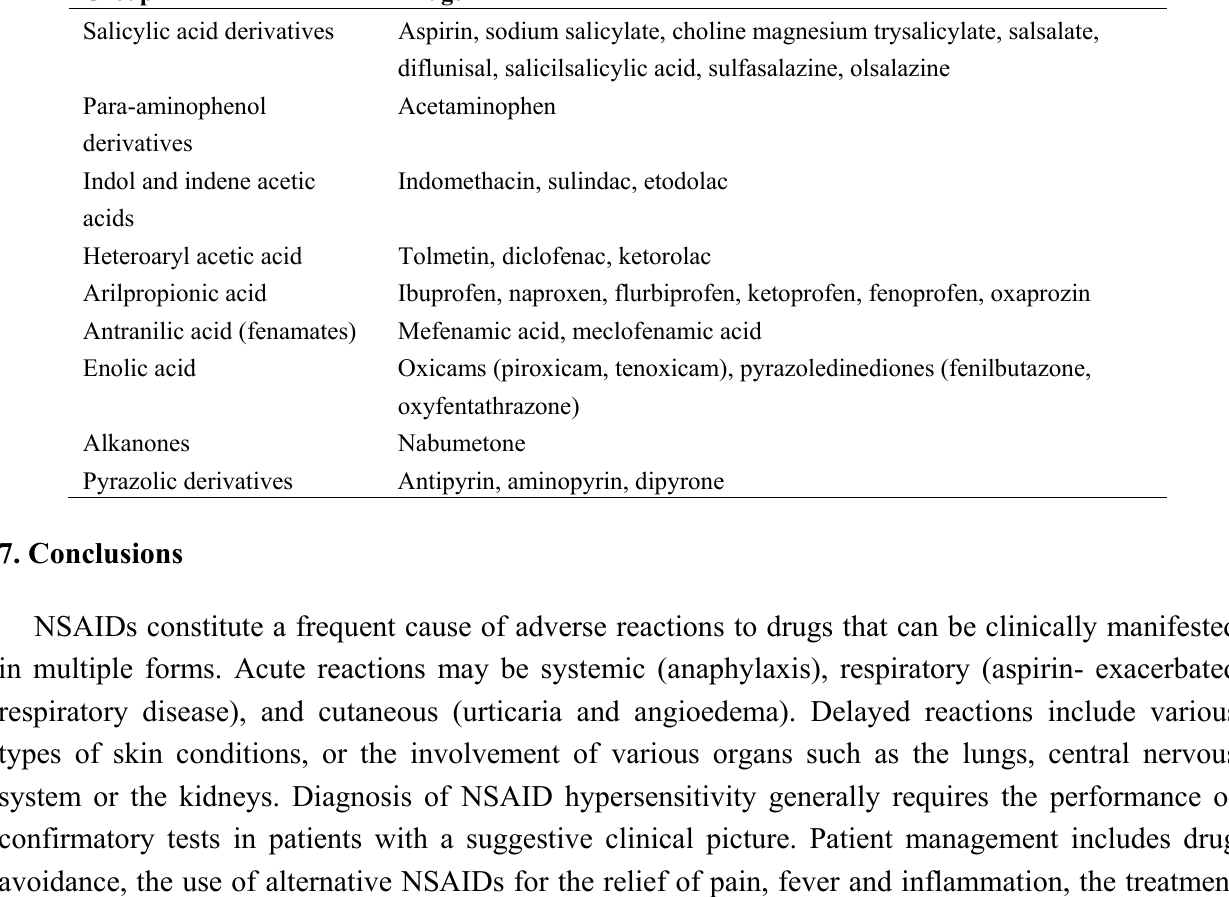
Table 3. Chemical Classification of non steroidal Anti-inflammatory Drugs (NSAIDs).